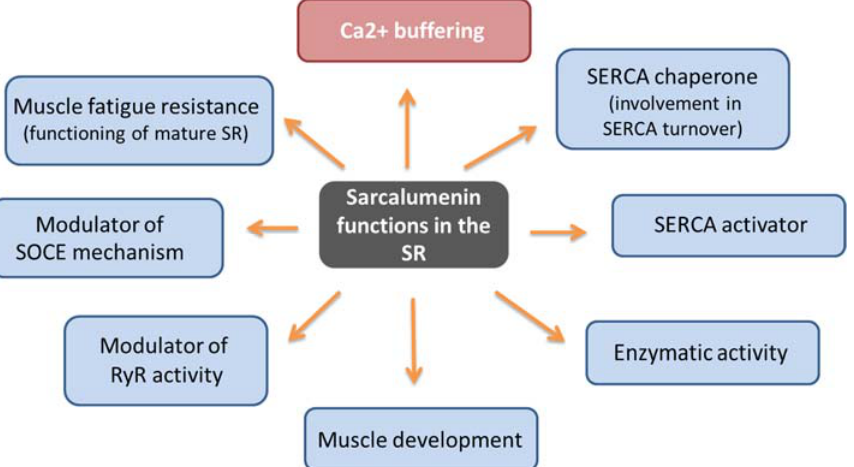
Figure 3. Schematic representation of sarcalumenin functions .